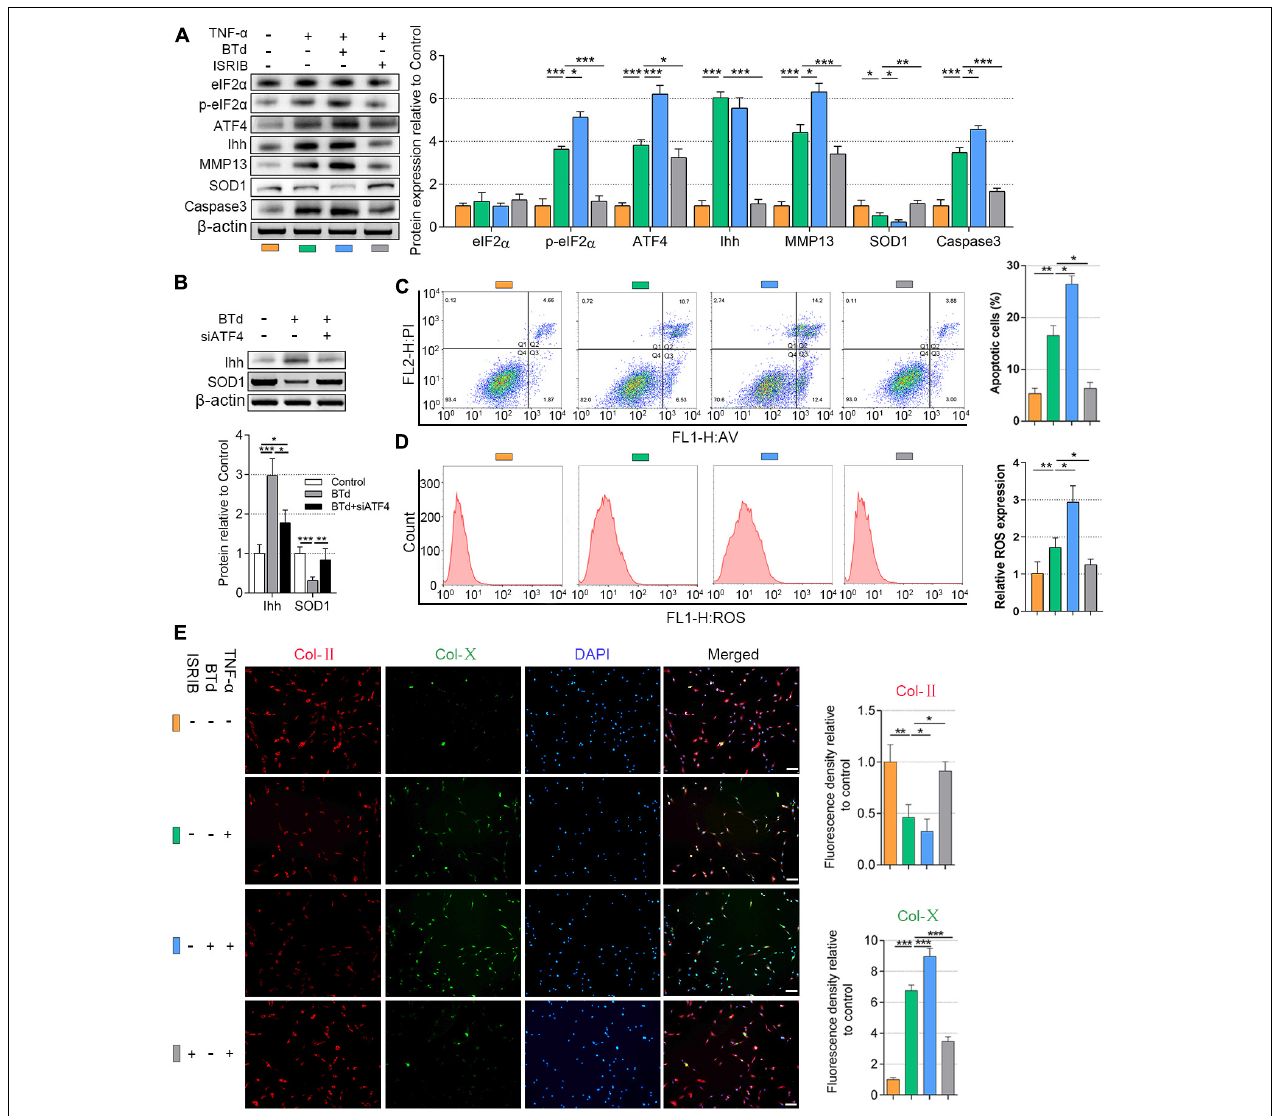
FIGURE 4 | Phosphorylation of eIF2 α affected ATF4, Ihh expression, oxidative stress, and apoptosis of human NP cells. NP cells were treated with 20 ng/ml of TNF- α for 3 days or simultaneously applied with BTd and ISRIB. (A) eIF2 α , p-eIF2 α , ATF4, Ihh, MMP13, SOD1, and Caspase3 protein levels were assessed by WB, measured by densitometric analyses, and expressed as folds relative to control. (B) Normal NP cells or ATF4-silenced NP cells were treated with BTd, and the Ihh expression and SOD1 expression were tested by WB. Flow cytometry assay and the corresponding statistical analysis of (C) cell apoptosis (%) and (D) ROS expression. (E) Representative images of IF staining with Col-II and Col-X, measured by densitometric analyses and expressed as folds relative to control (scale bar = 100 µ m). Data are presented as means ± SD ( n = 7). * p < 0.05; ** p < 0.01; *** p < 0.001; the orange column indicates control NP cells without any treatments, the green column indicates NP cells treated with TNF- α , the blue column indicates NP cells treated with TNF- α and BTd, and the gray column indicates NP cells treated with TNF- α and ISRIB. eIF2 α , eukaryotic initiation factor-2 α ; ATF4, activating transcription factor 4; Ihh, Indian hedgehog; NP, nucleus pulposus; TNF, tumor necrosis factor; p-eIF2 α , phosphorylated eukaryotic initiation factor-2 α ; MMP13, matrix metalloproteinase-13; SOD1, superoxide dismutase 1; WB, western blot; ROS, reactive oxygen species; IF, immunofluorescence; Col-II, collagen II; Col-X, collagen